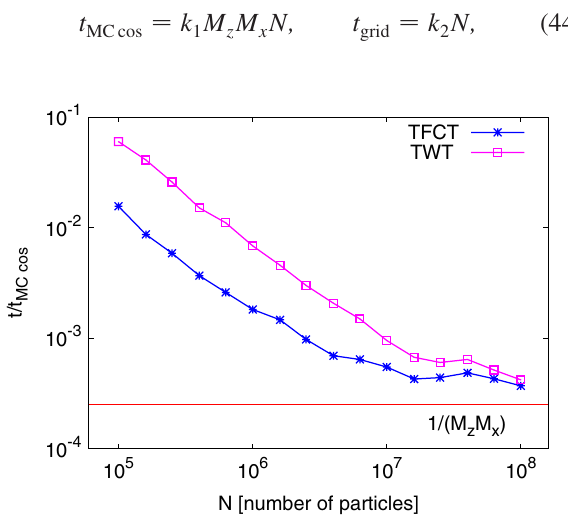
FIG. 14. Direct comparison of efficiency of the three tech- niques: execution times of the two alternative techniques scaled with the execution time of the Monte Carlo cosine approxima- tion used in [11], as a function of the number of particles N . The ¼ 1 = ð M Þ , to which M red horizontal line denotes t=t x z MCcos ¼ 1024 , N ¼ 128 , the ratios tend. The grid resolution is N z x and the number of cosine basis functions in the expansion is ¼ 40 and M ¼ 100 . The wavelet family used is Daubechies M x z of order 10. (cid:8) ¼ 100 (cid:9) m and A ¼ 0 : 05